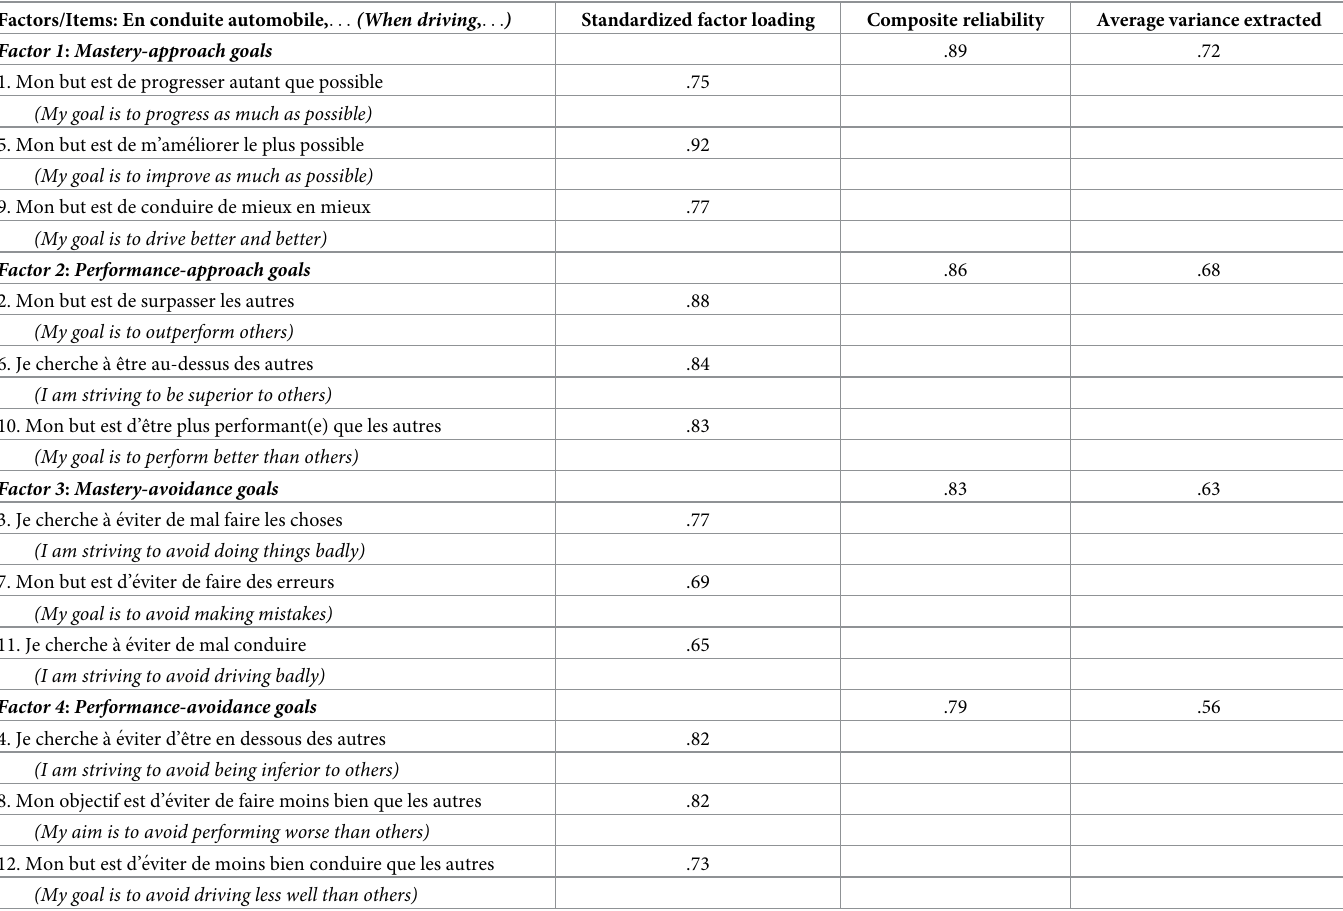
Table 3. French version of the AGQ-D (and English translation), standardized factor loading, construct reliability, and average variance extracted. Factors/Items: En conduite automobile, ... (When driving , ...